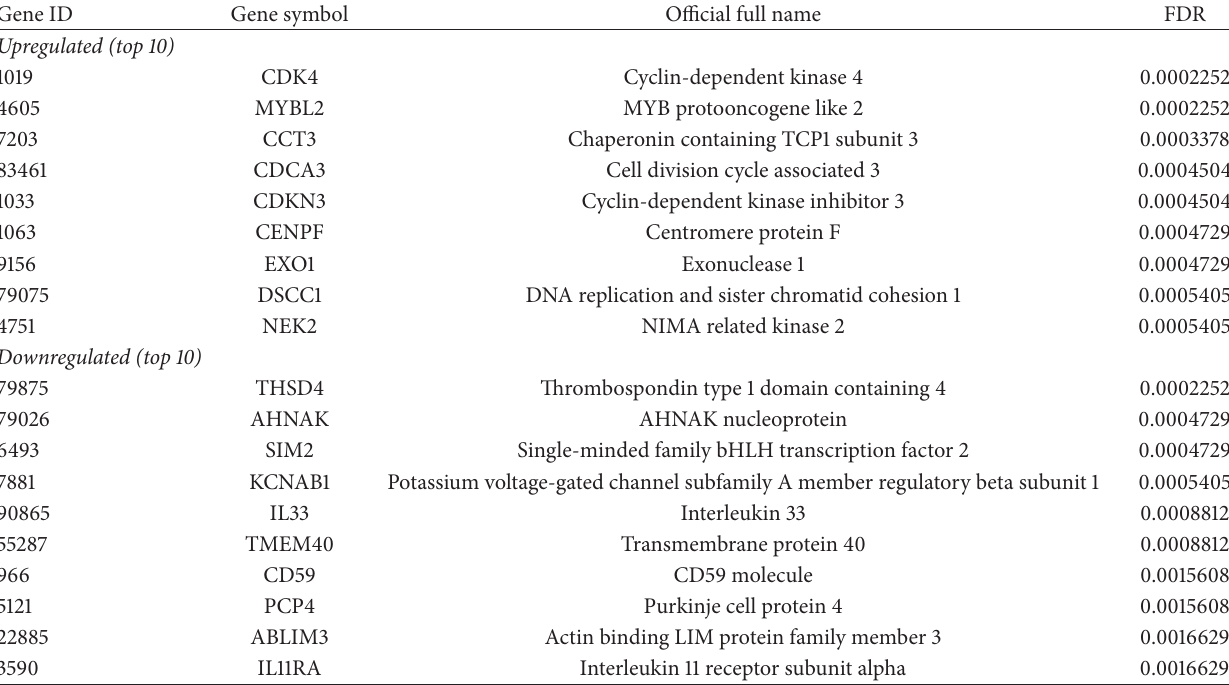
Table 2: The top 10 up-regulated and top 10 down-regulated DEGs in